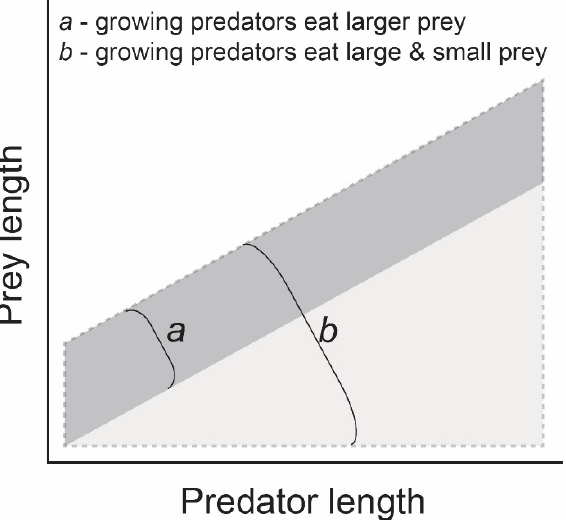
Figure 1. Conceptual prey–predator length relationships: (a) piscivores that feed on increasingly larger prey as they grow, and (b) piscivores that feed on both large and small prey. Across the United States, Brown Trout are the third most widely introduced species Invasive predators have contributed to declines in biodiversity worldwide [8–13].